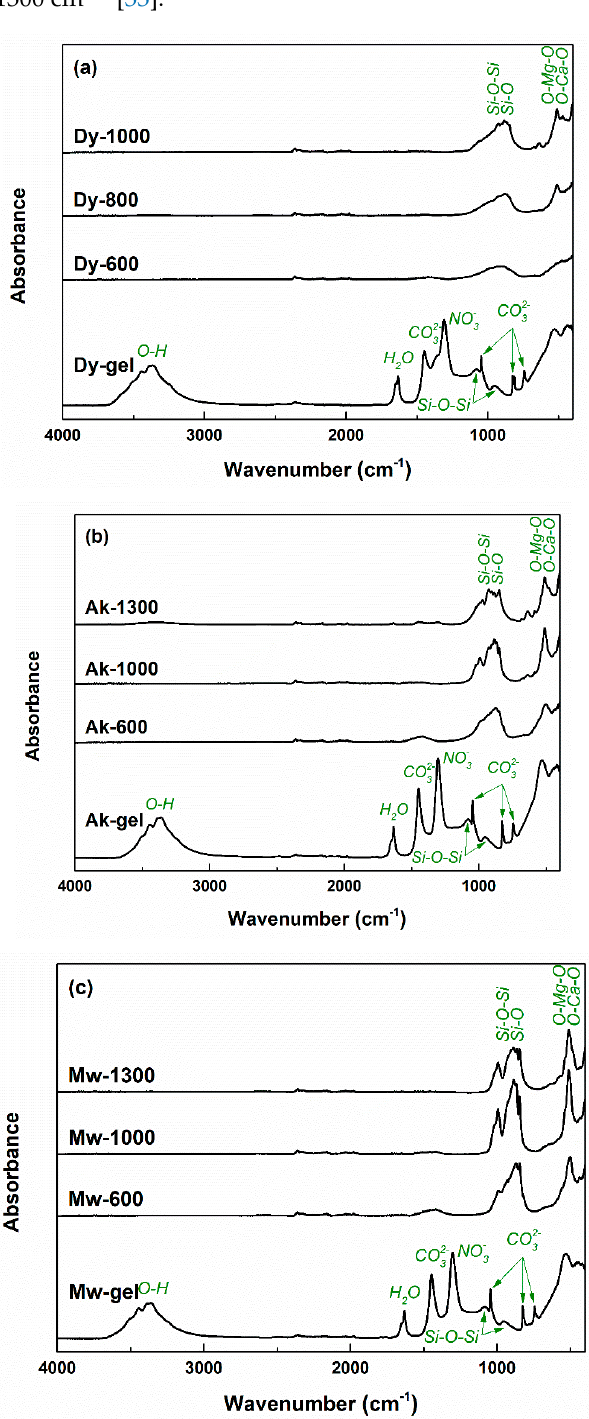
Figure 7. FTIR spectra of the dry gels and ceramics corresponding to: ( a ) diopside; ( b ) akermanite; and ( c ) merwinite compositions.